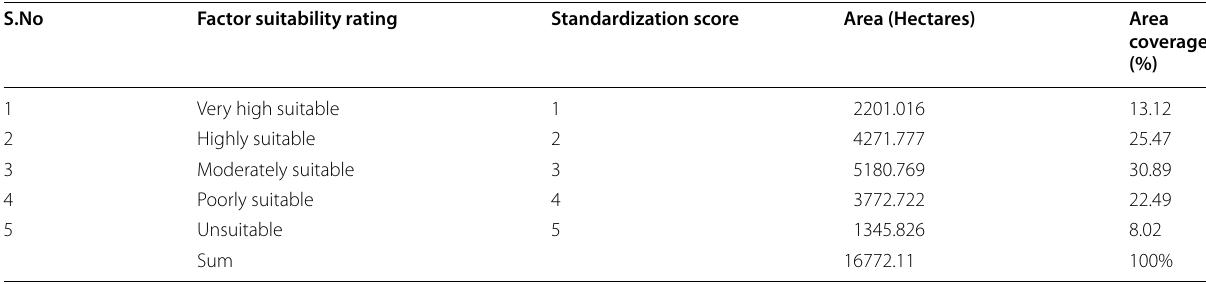
Table 7 Area coverage of UGS suitability map of DMC